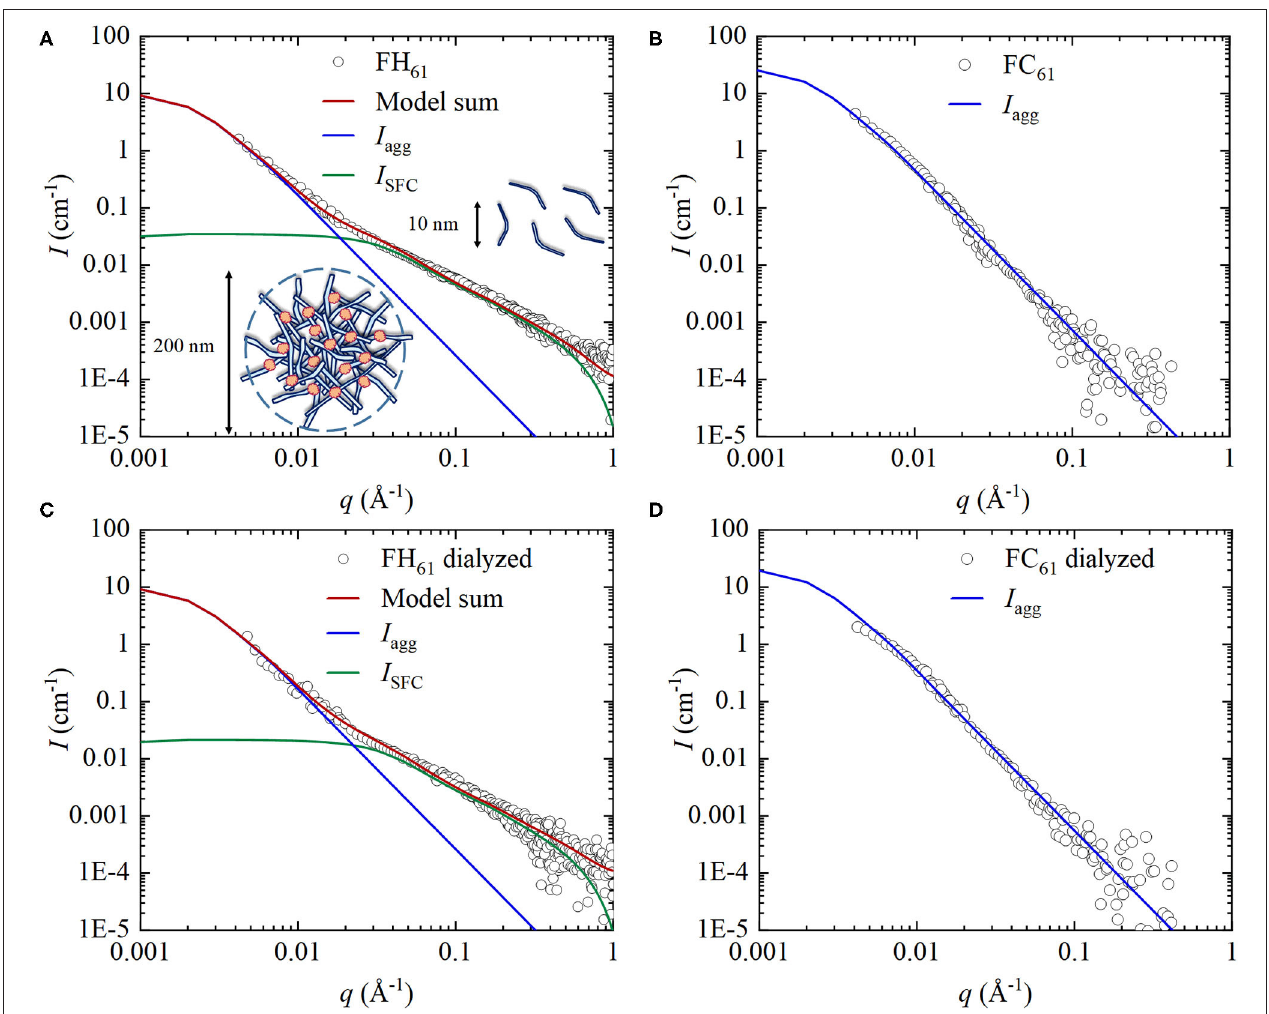
FIGURE 5 | SAXS profiles obtained from (A) FH 61 , (B) FC 61 and after dialysis (C) FH 61 , (D) FC 61 . Green lines represent model scattering from semi-flexible cylinders (depicted as coils of about 10nm diameter), I SFC ( q ). Blue lines represent model scattering from fractal clusters I agg ( q ) (depicted as aggregates of about 200nm diameter). Red lines represent the full scattering model, i.e., I ( q ) = I SFC ( q ) + I agg ( q